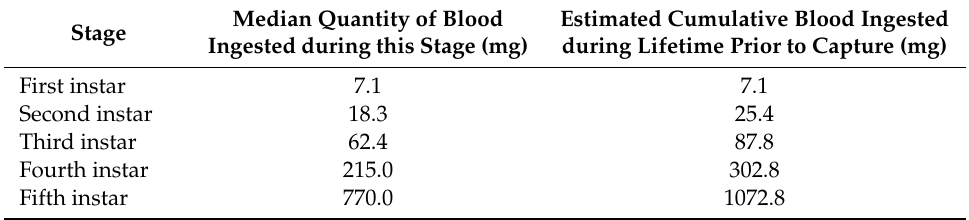
Table A1. Blood meal sizes observations for laboratory reared insects [4] and estimates of cumulative blood ingested by captured wild Triatoma infestans